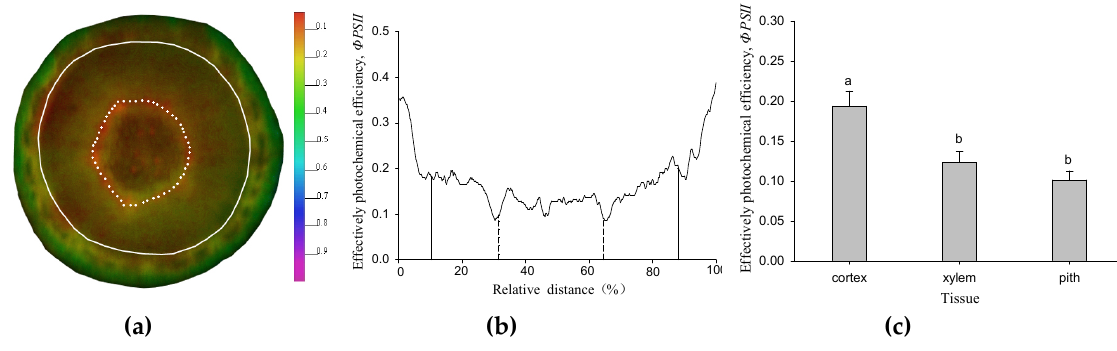
Figure 1. The spatial heterogeneity of Φ PSII in the twig cross section of Salix matsudana . ( a ) The Φ PSII image of the twig cross section. The different colors indicate the different values of Φ PSII . The solid line indicates the position of the cambium, while the dotted line indicates the border between xylem and pith. ( b ) Φ PSII was measured along the transection of the twig cross section. Transection (from 9 o’clock to 3 o’clock direction) was taken from the Φ PSII images of ( a ). The solid line indicates the position of the cambium, while the dotted line indicates the border between the xylem and pith. ( c ) the difference of Φ PSII among the tissues in the twig cross section under 17 µ mol m − 2 s − 1 . Data were mean ± SE (standard error) with n = 6 and different lowercase letters indicate a significant ( p < 0.05) difference.